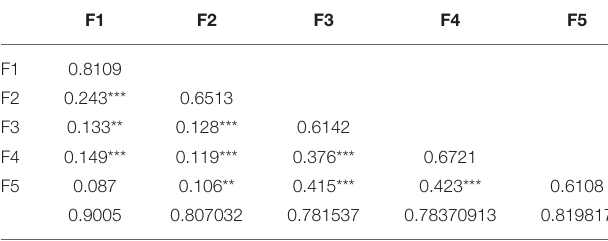
TABLE 7 | Discriminant